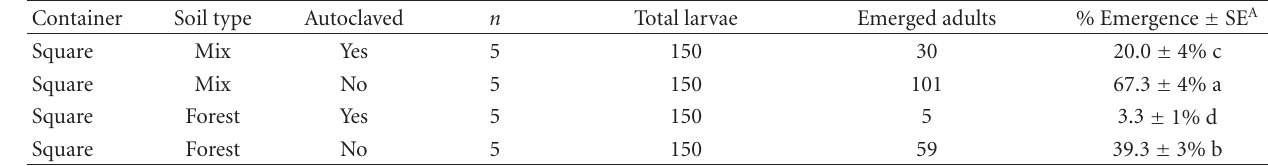
Table 2: Total number of Laricobius nigrinus larvae, emerged adults, and percent emergence in each treatment. Container Soil type Autoclaved n Total larvae Square Mix Square Square